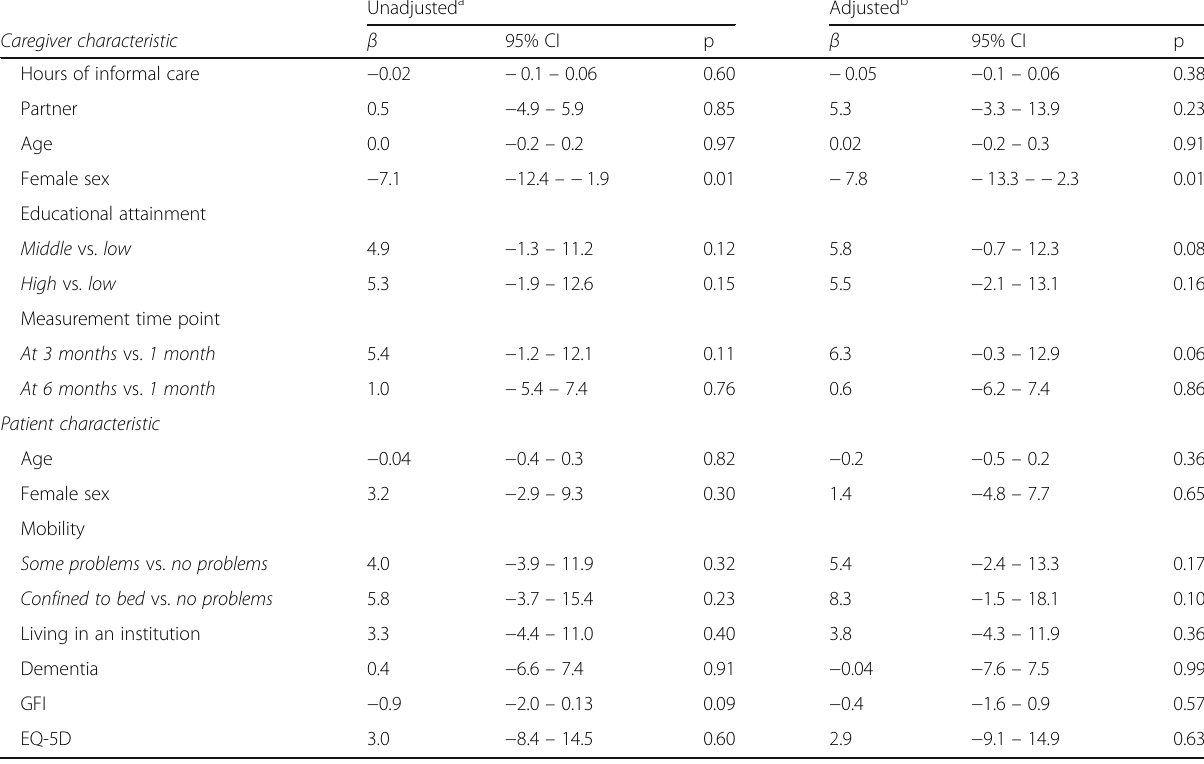
Table 4 Univariate- and multivariable linear regression results for association with CarerQoL of informal caregivers Unadjusted